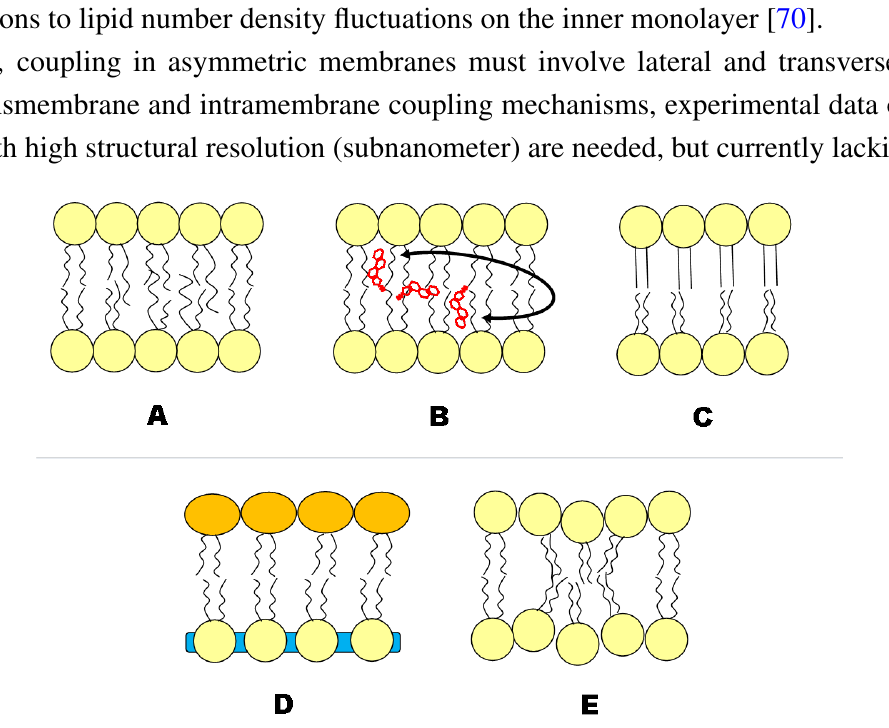
Putative transbilayer coupling mechanisms in asymmetric lipid